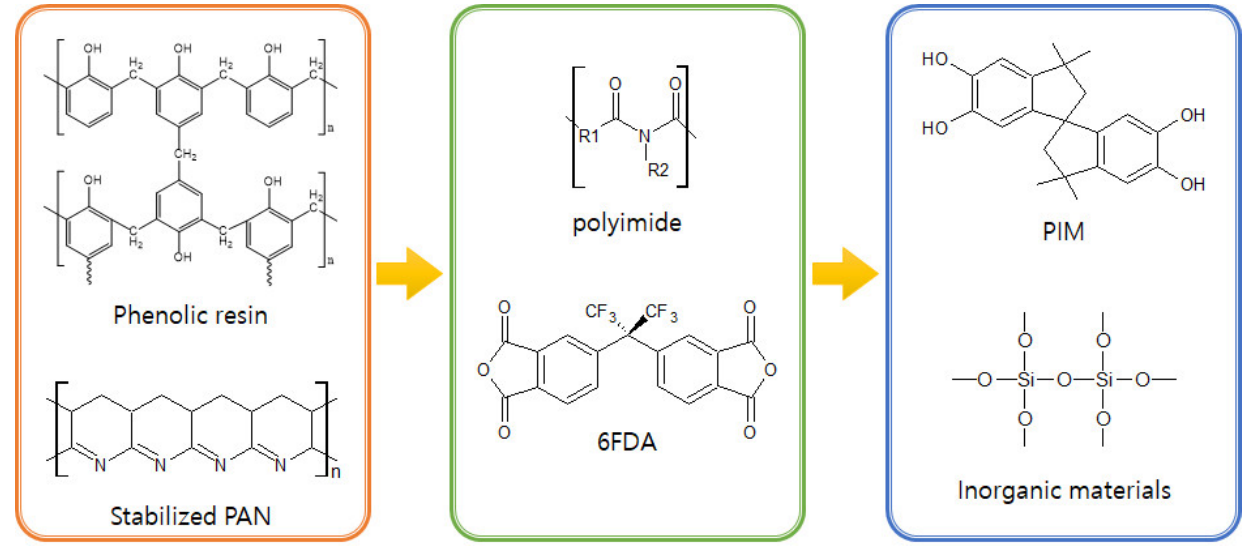
Figure 19. Progress of polymer precursor materials for CMS membrane.